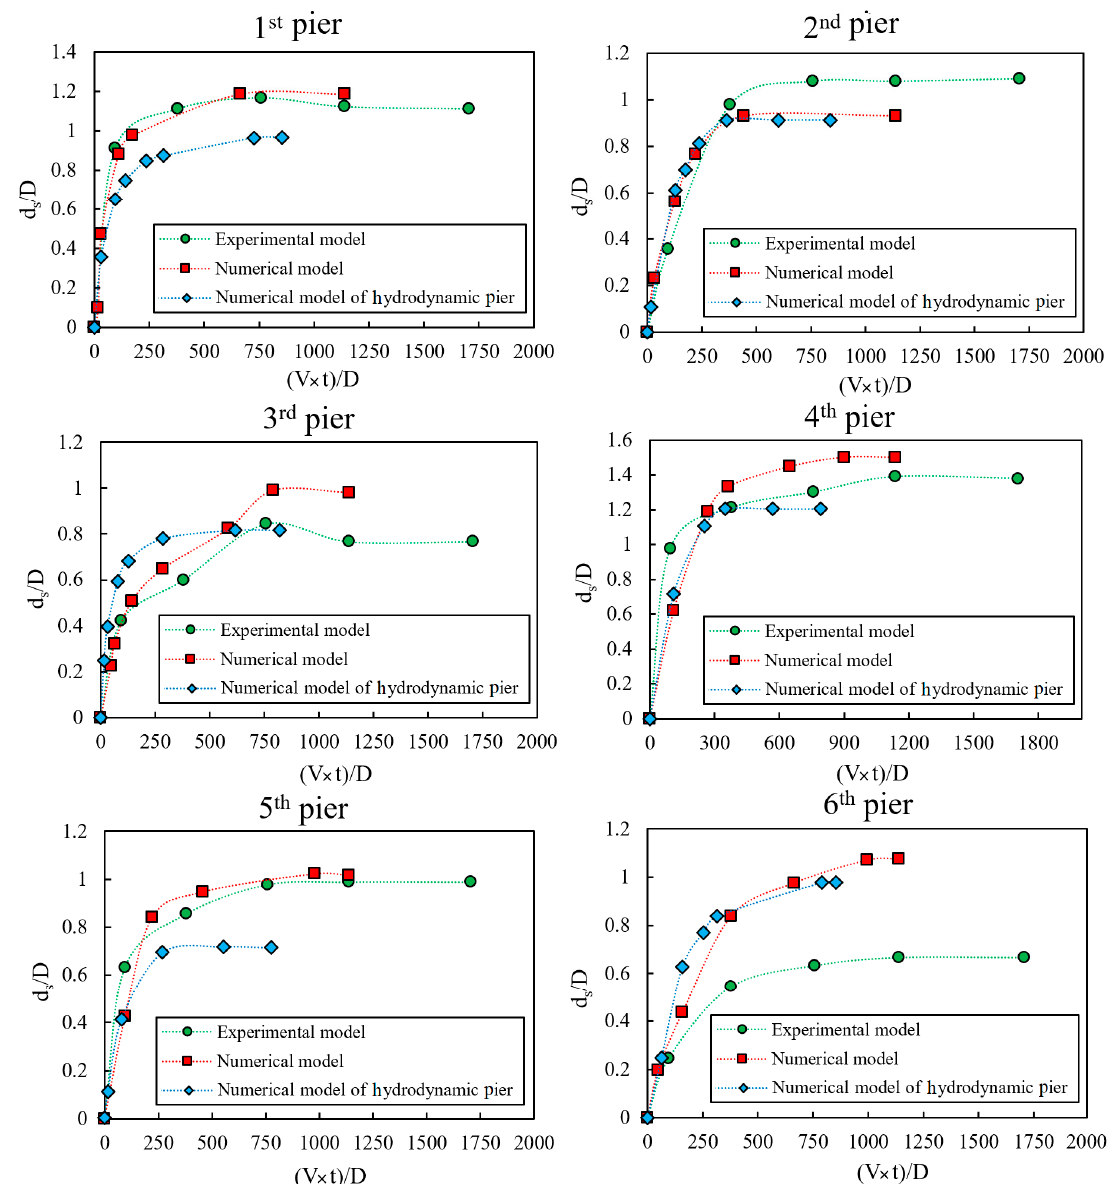
Figure 7. Scour depths for the circular and hydrodynamic piers.